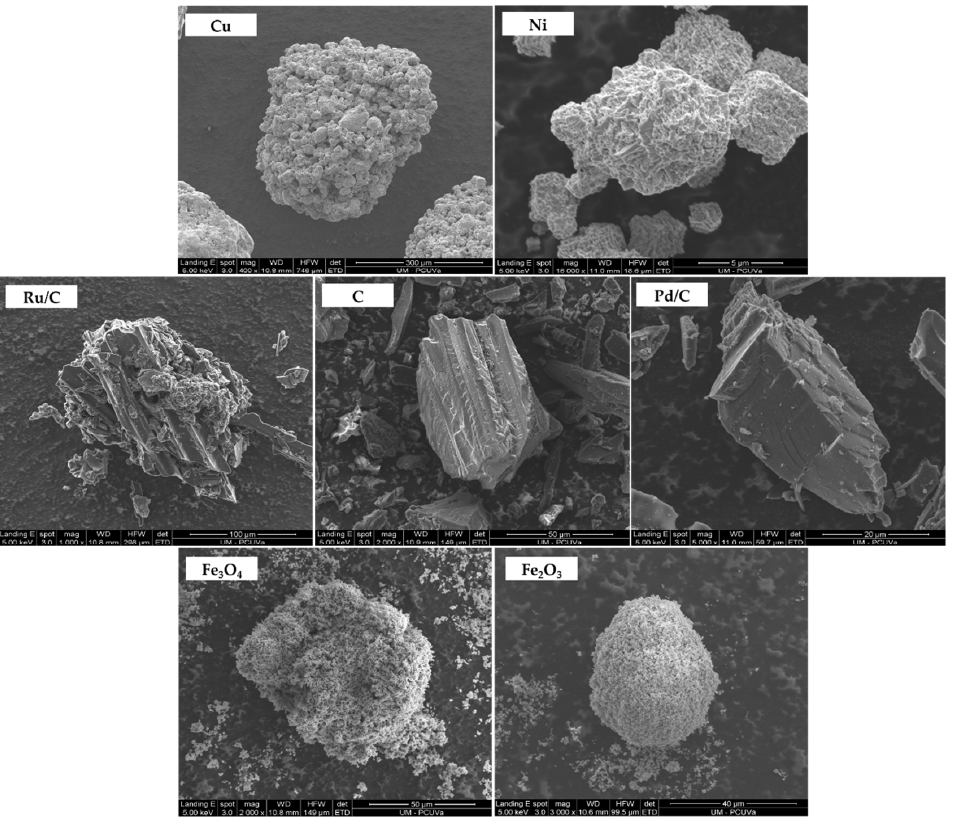
Figure 1. SEM images of the catalyst